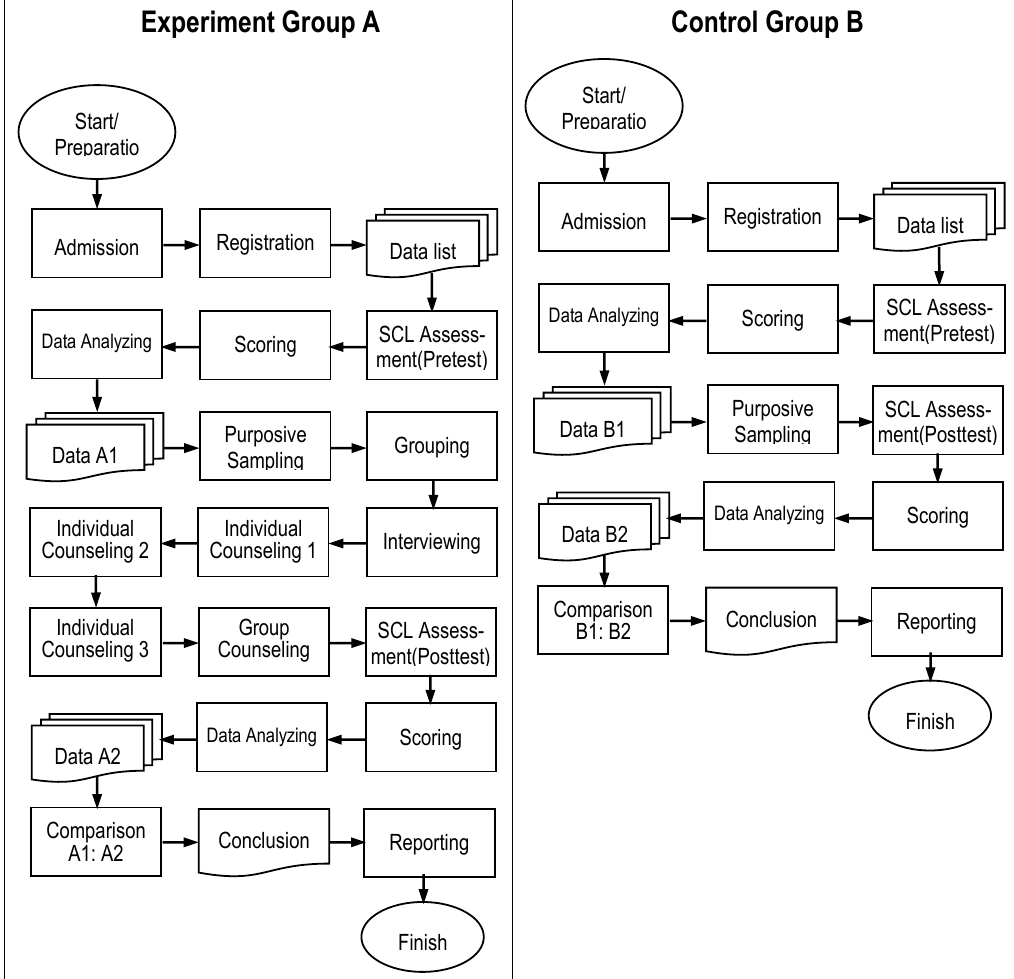
Figure 3. Stages of Research